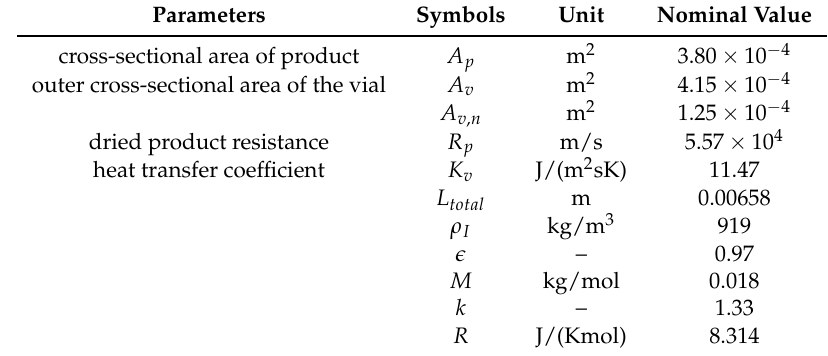
Table 1. Nominal values of the model parameters and the initial conditions for the primary drying model [10].